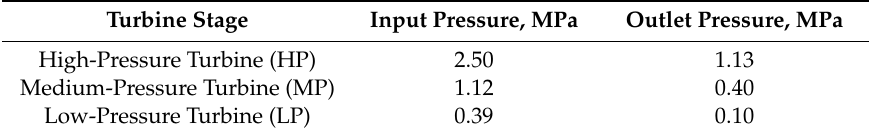
Table 1. Parameters of the multistage turbine in a “TICC-500” CAES pilot system